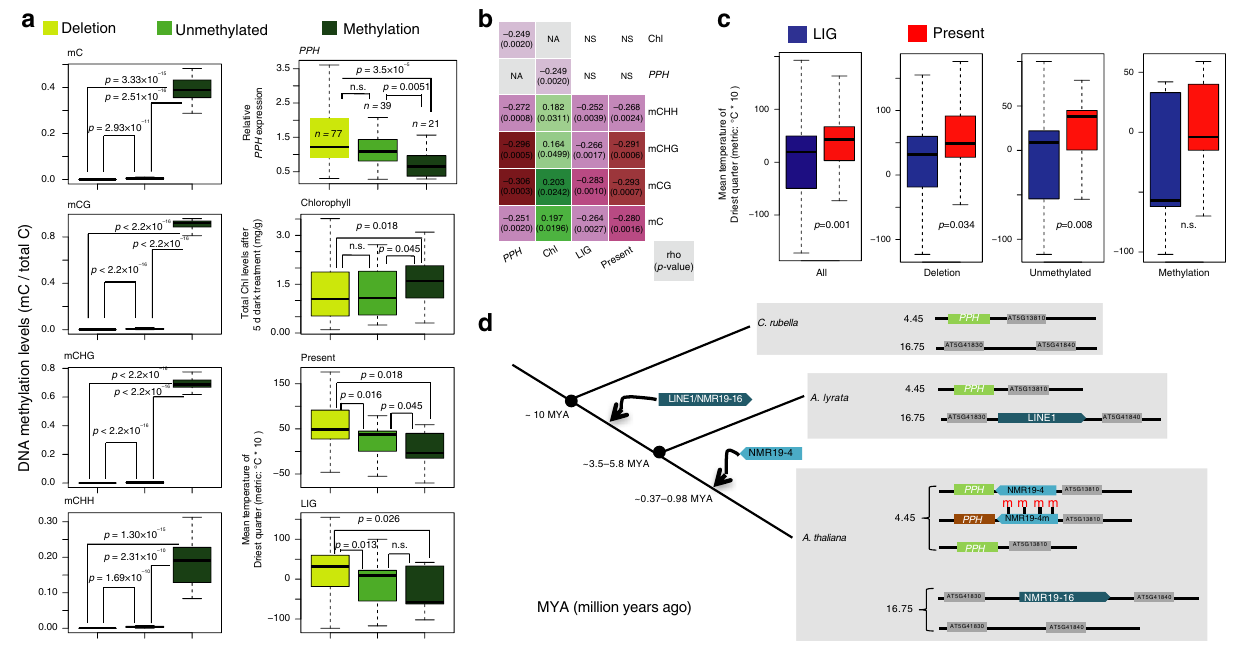
Fig. 7 Association of DNA methylation of NMR19-4 with climate parameters at place of origin and analysis of NMR19 insertion. a Box-plots show methylation levels of cytosine in various sequence contexts (left), PPH gene expression, and chlorophyll contents, mean temperature of Driest quarter in three groups of accessions classi fi ed by methylation status of NMR19-4. Left, methylation level was calculated from the published BS-seq data 39 . Right, from upper to bottom: expression level of PPH , chlorophyll content, mean temperature of Driest quarter in present and last interglacial (LIG, about 120,000 – 140,000 years ago). p -value was calculated by Wilcoxon test. The box represents the distance between the 1st and 3rd quartiles and the whiskers are 1.5*IQR where IQR = Q3 – Q1 (the same as below). b Pairwise Spearman correlation coef fi cients of NMR19 methylation level, PPH expression, chlorophyll content, temperature of Driest quarter in present and LIG. The numbers indicate correlation coef fi cients (rho) and p -values. Correlations to other climate parameters are listed in Supplementary Data. c The change of mean temperature of Driest quarter between present and LIG at the place of origin for accessions in different groups. p -value was calculated by Wilcoxon tests. d The pattern of NMR19 in Capsella rubella, A.thaliana , Arabidopsis lyrata (modi fi ed from published paper 62 ). NMR19-4 is unique to A.thaliana and originated from a retrotransposition event that occurred 0.37 – 0.98 MYA. 4.45 and 16.75 represent two genomic locations of NMR19 on chromosome